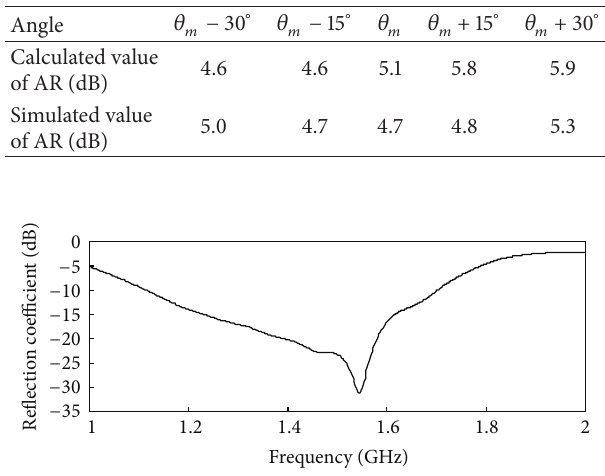
Figure 8: Simulated results of reflection coefficient.